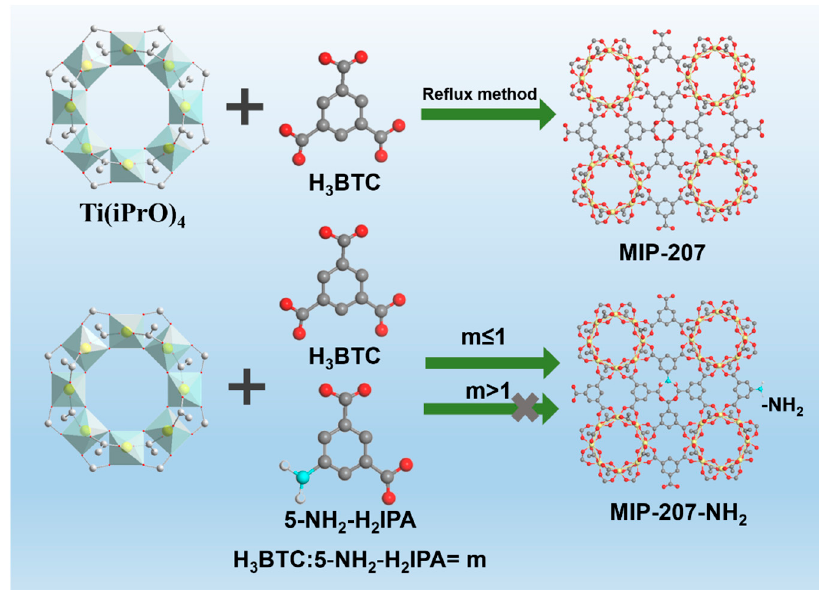
Figure 1. Schematic Diagram of MIP-207 and amine-functionalized MIP-207; Ti is shown in yellow, C in gray, O in red, N in light blue, and H in white.